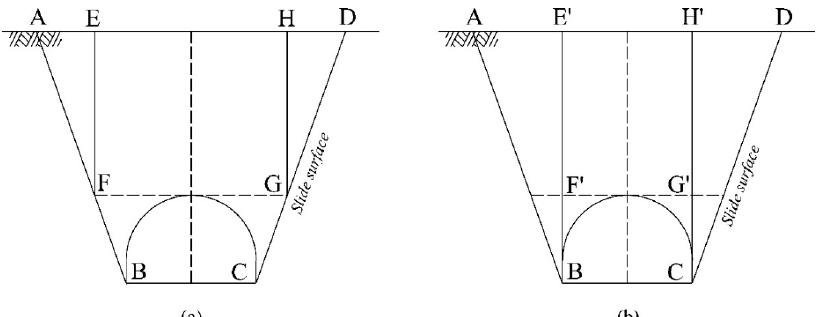
Figure 1. Slide surface in the calculation of the surrounding rock pressure: ( a ) Calculation method proposed by K. Terzaghi [6]; ( b ) Calculation method proposed by A. Bierbaumer